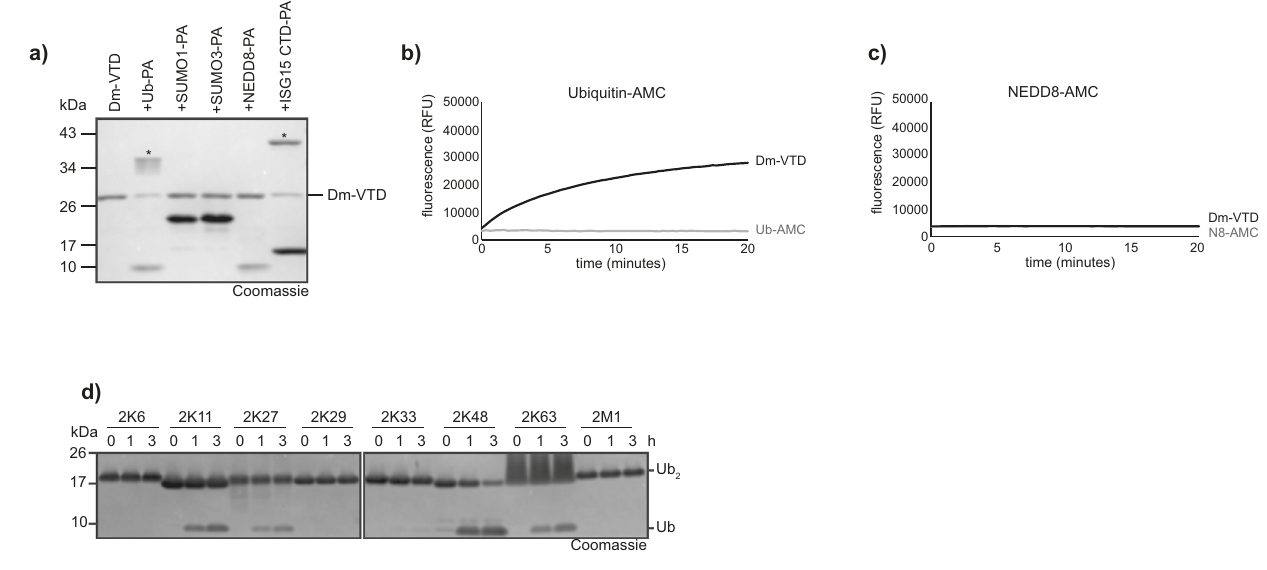
Fig. 7 | Activity of invertebrate VTDs. a Reaction of Dm-VTD with Ub and Ubl activity-based probes. Asterisks mark the shifted bands after reaction. b-c Activity of Dm-VTDagainstUbiquitin-AMC( b )andNEDD8-AMC( c ).TheRFU valuesarethe